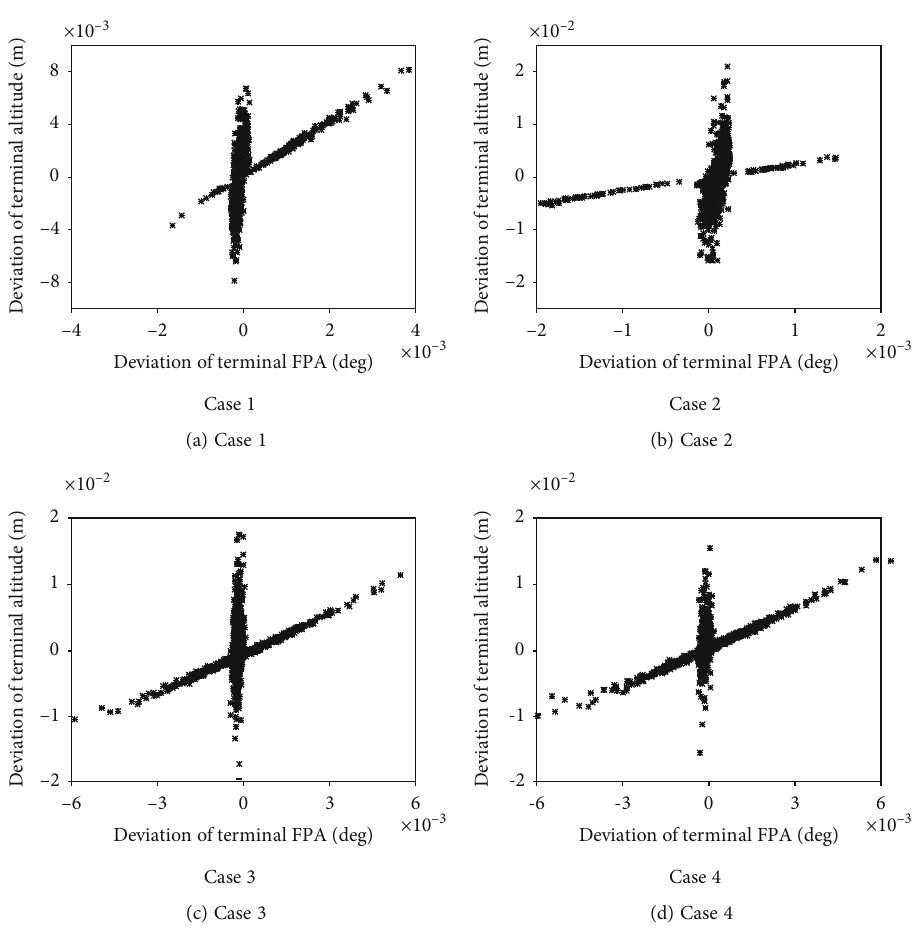
Figure 10: Terminal deviations of the Monte Carlo simulations. Table 9: The statistics on the terminal deviations of the Monte Carlo